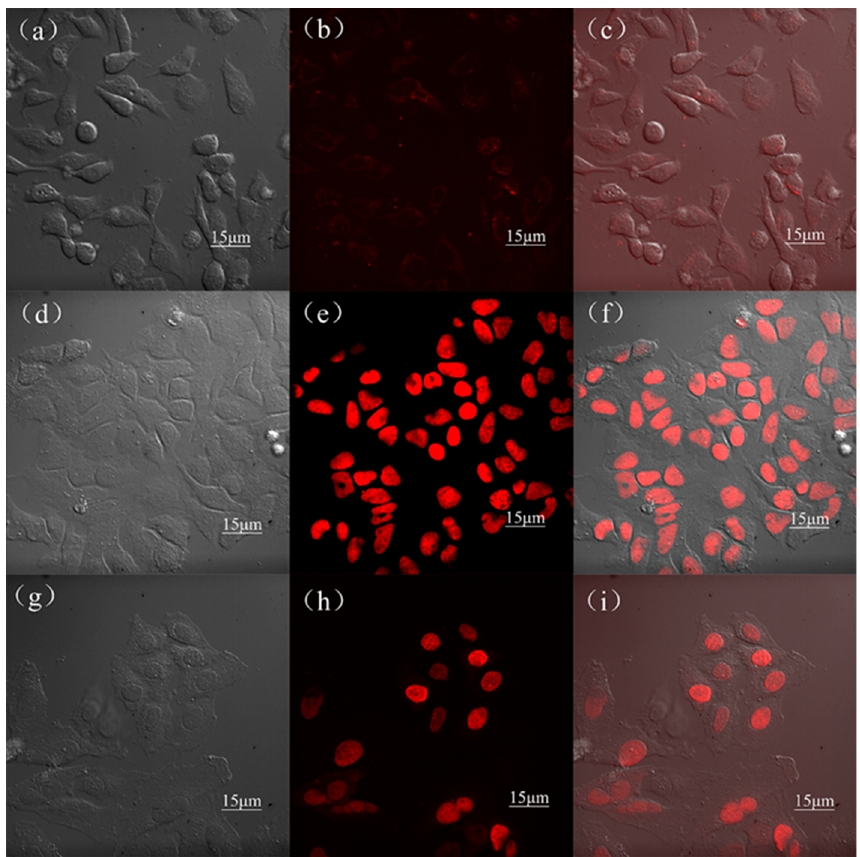
Figure 2. Differential interference contrast (DIC) and fluorescence microscopic images of HeLa cells. The DIC images of cells from: ( a ) the control group, ( d ) cordycepin-12 h group, ( g ) cordycepin-48 h group; the fluorescence images of cells from: ( b ) the control group, ( e ) the cordycepin-12 h group, ( h ) the cordycepin-48 h group; the merged DIC and fluorescence images are shown in ( c ), ( f ), and ( i ), respectively.